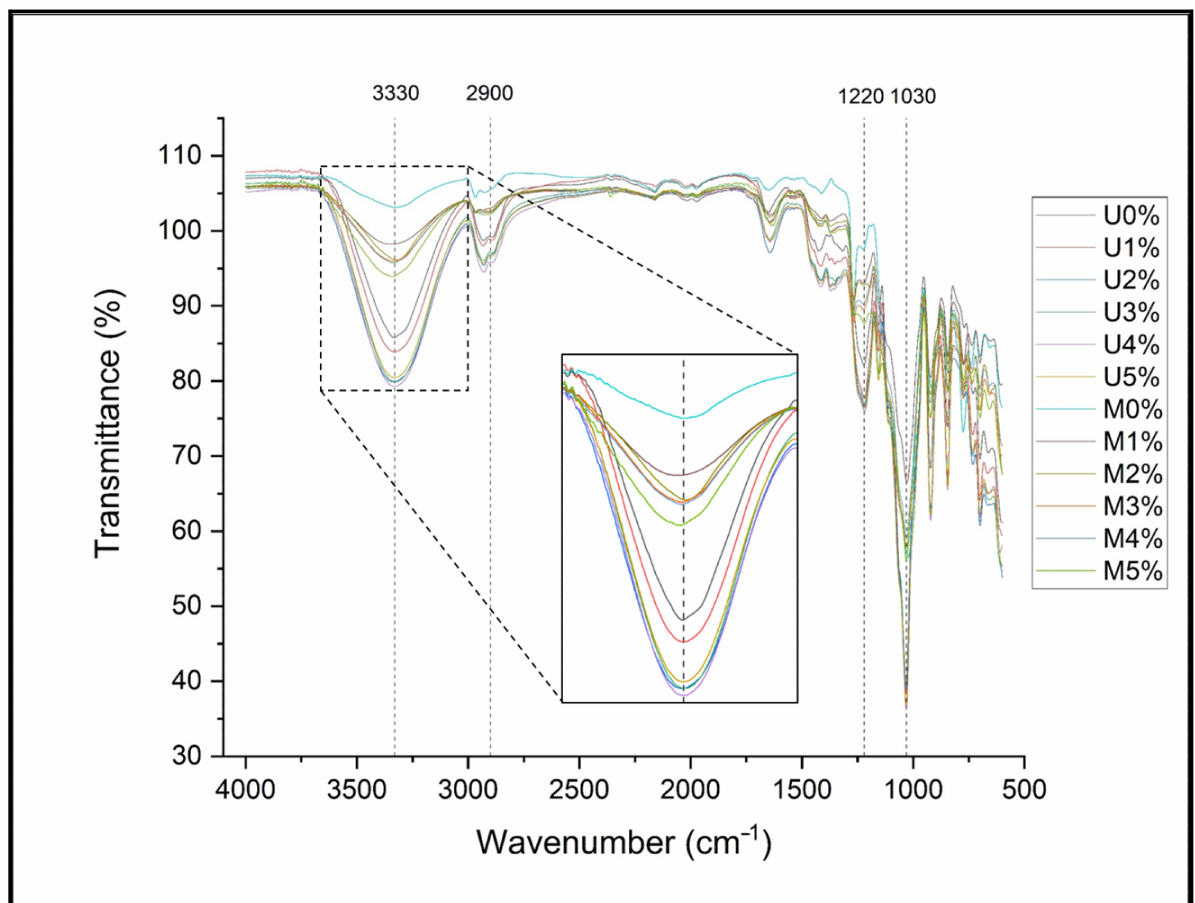
Figure 2. Overlapring FT-IR spectra of seaweed/CNF composite